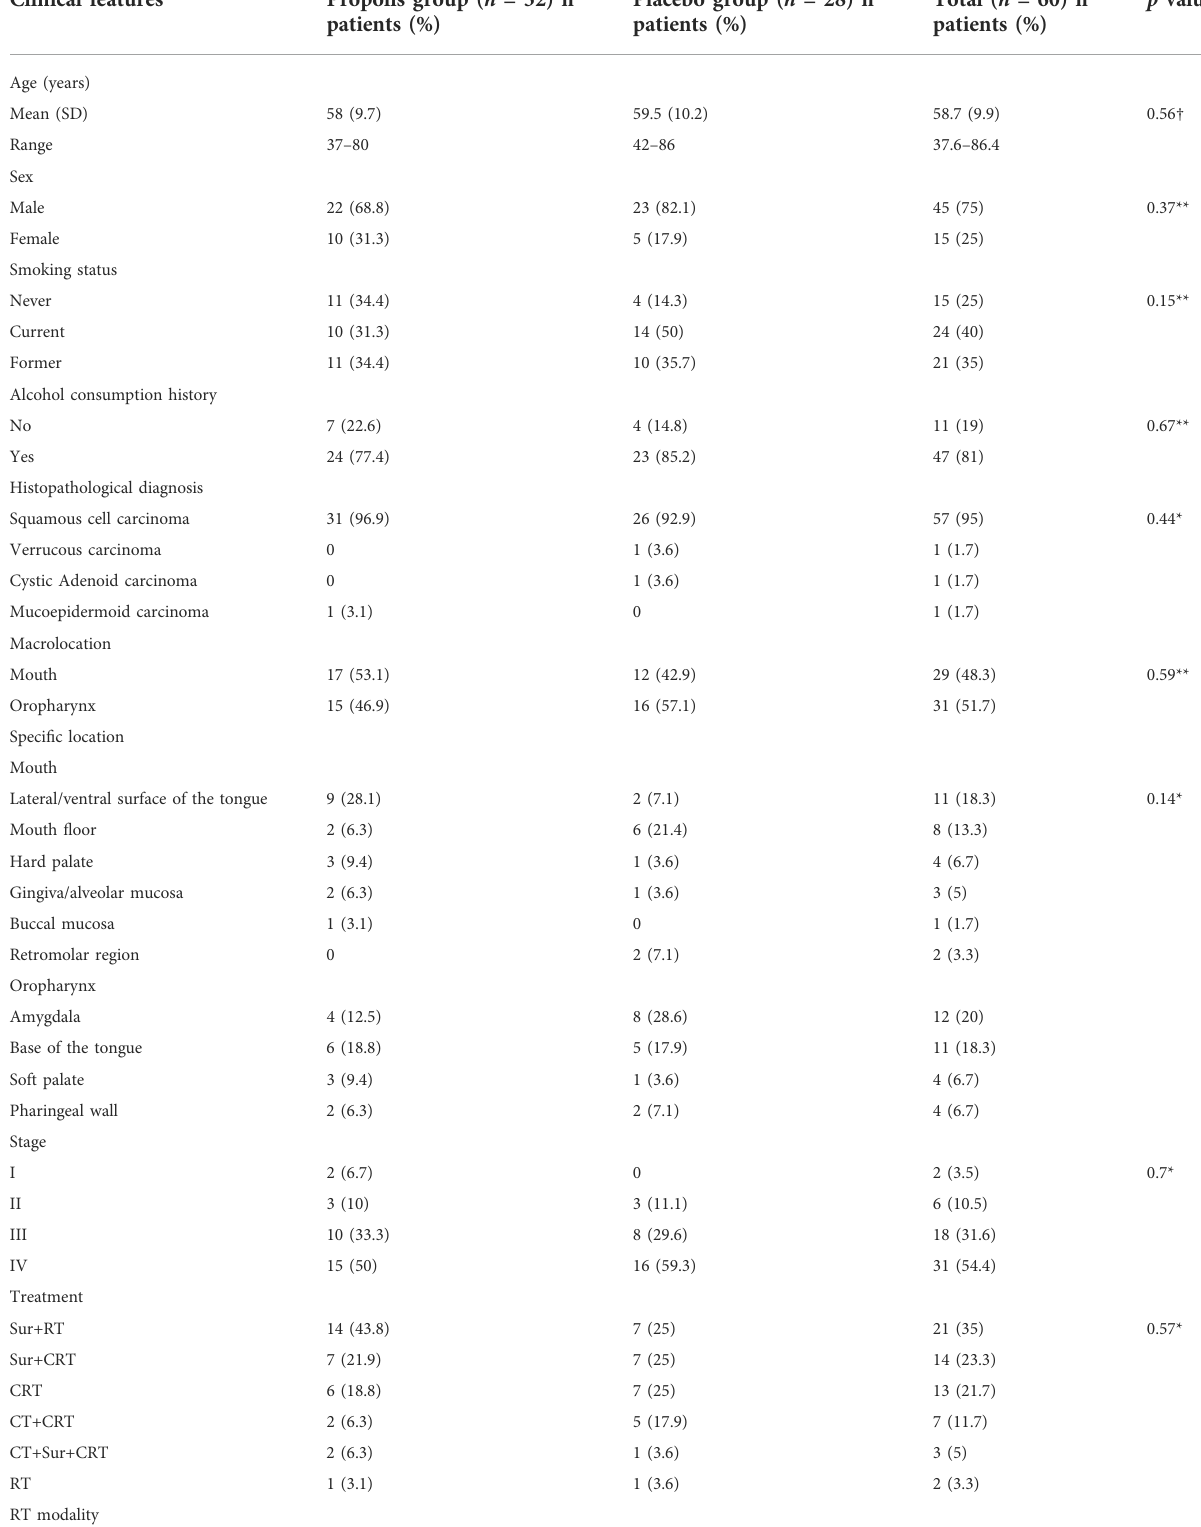
TABLE 1 Demographic and clinicopathological features of patients in